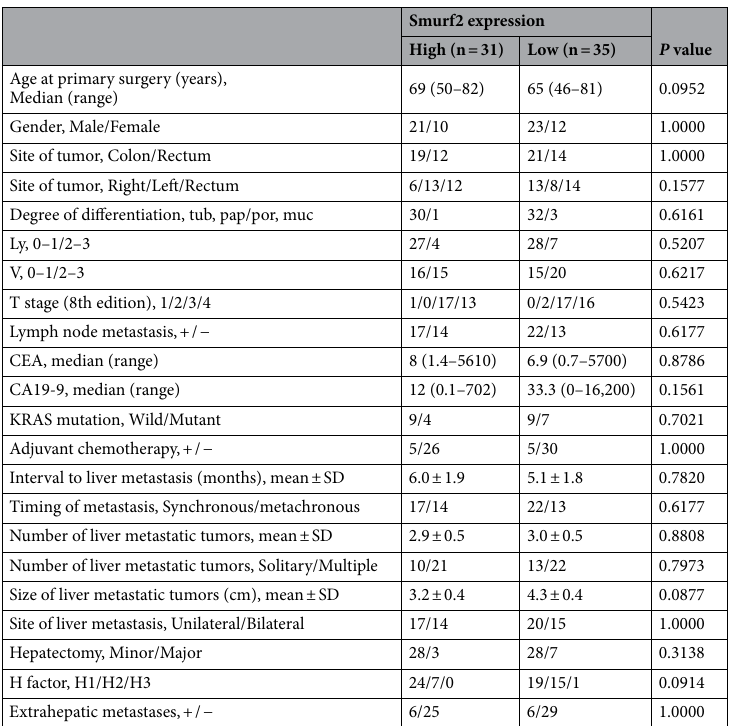
Table 1. Clinicopathologic features of patients diagnosed with colorectal cancer showing high and low Smad ubiquitination regulatory factor 2 (Smurf2) expression. CEA, carcinoembryonic antigen; CA19-9, carbohydrate antigen 19–9; KRAS, Kirsten rat sarcoma viral oncogene.